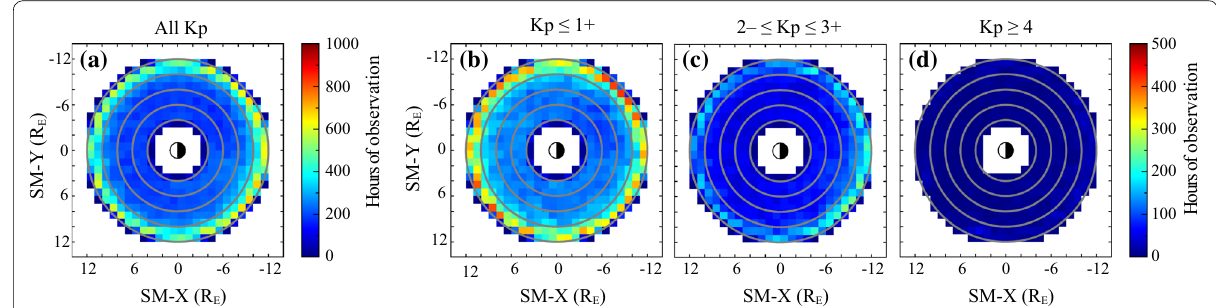
Fig. 2 a The distribution of total observation time of THEMIS probes (A, D, and E), projected onto the solar magnetic (SM) x – y plane, near the magnetic equator (|MLAT| 5°) from 2008 to 2014. b – d The total observation time under different geomagnetic conditions: quiet ( Kp ≤ moderate (2 Kp 3 ), and disturbed ( Kp 4) intervals, − ≤ ≤ + ≥